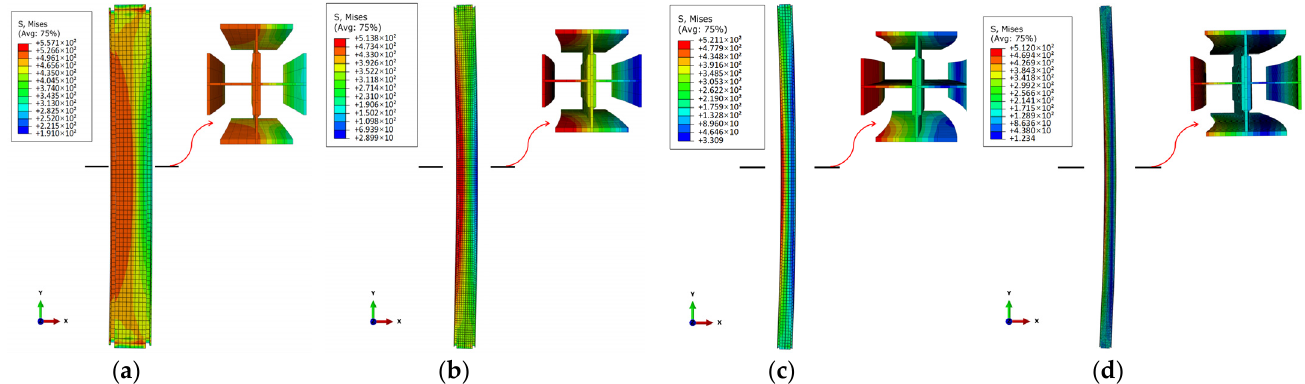
Figure 9. The FCHC-2-3 series illustrates the typical failure mode of the flexural–torsional buckling: ( a ) FCHC-2-3-3; ( b )